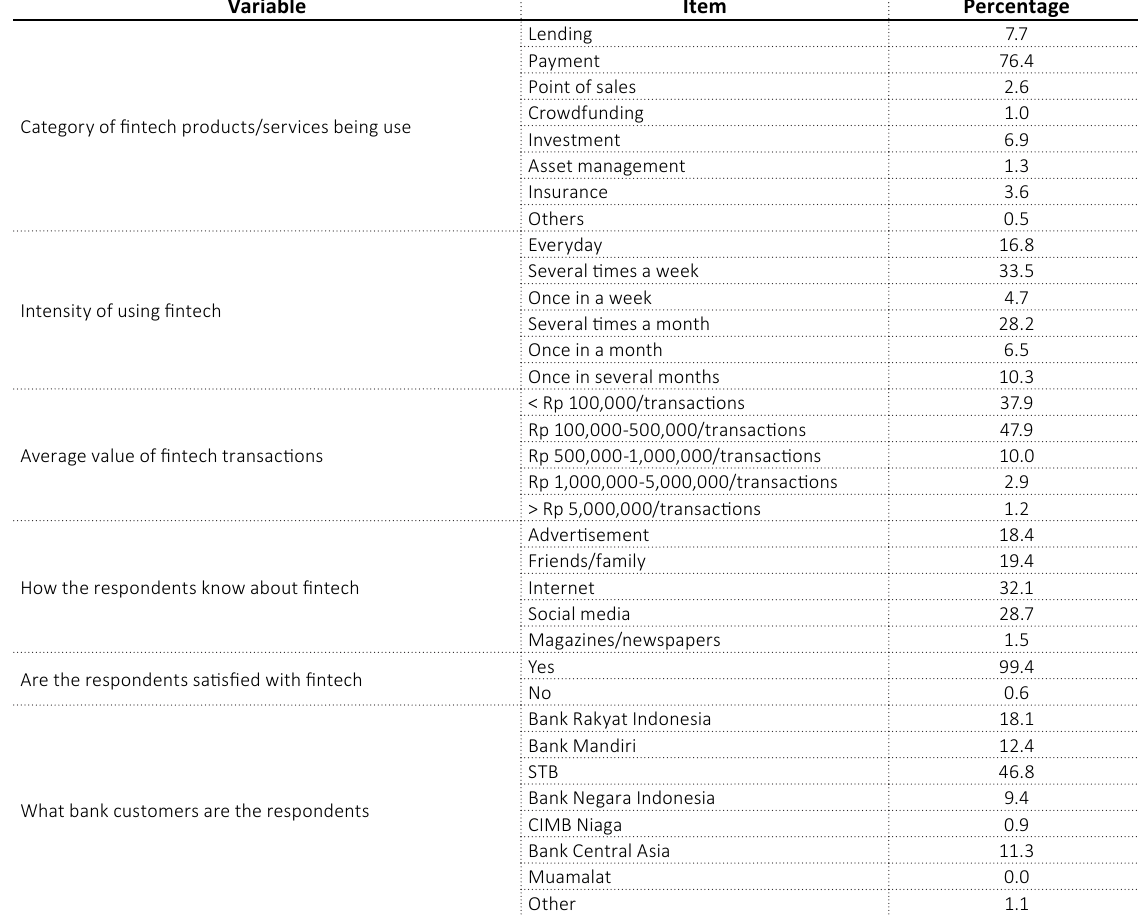
Category of fintech products/services being use